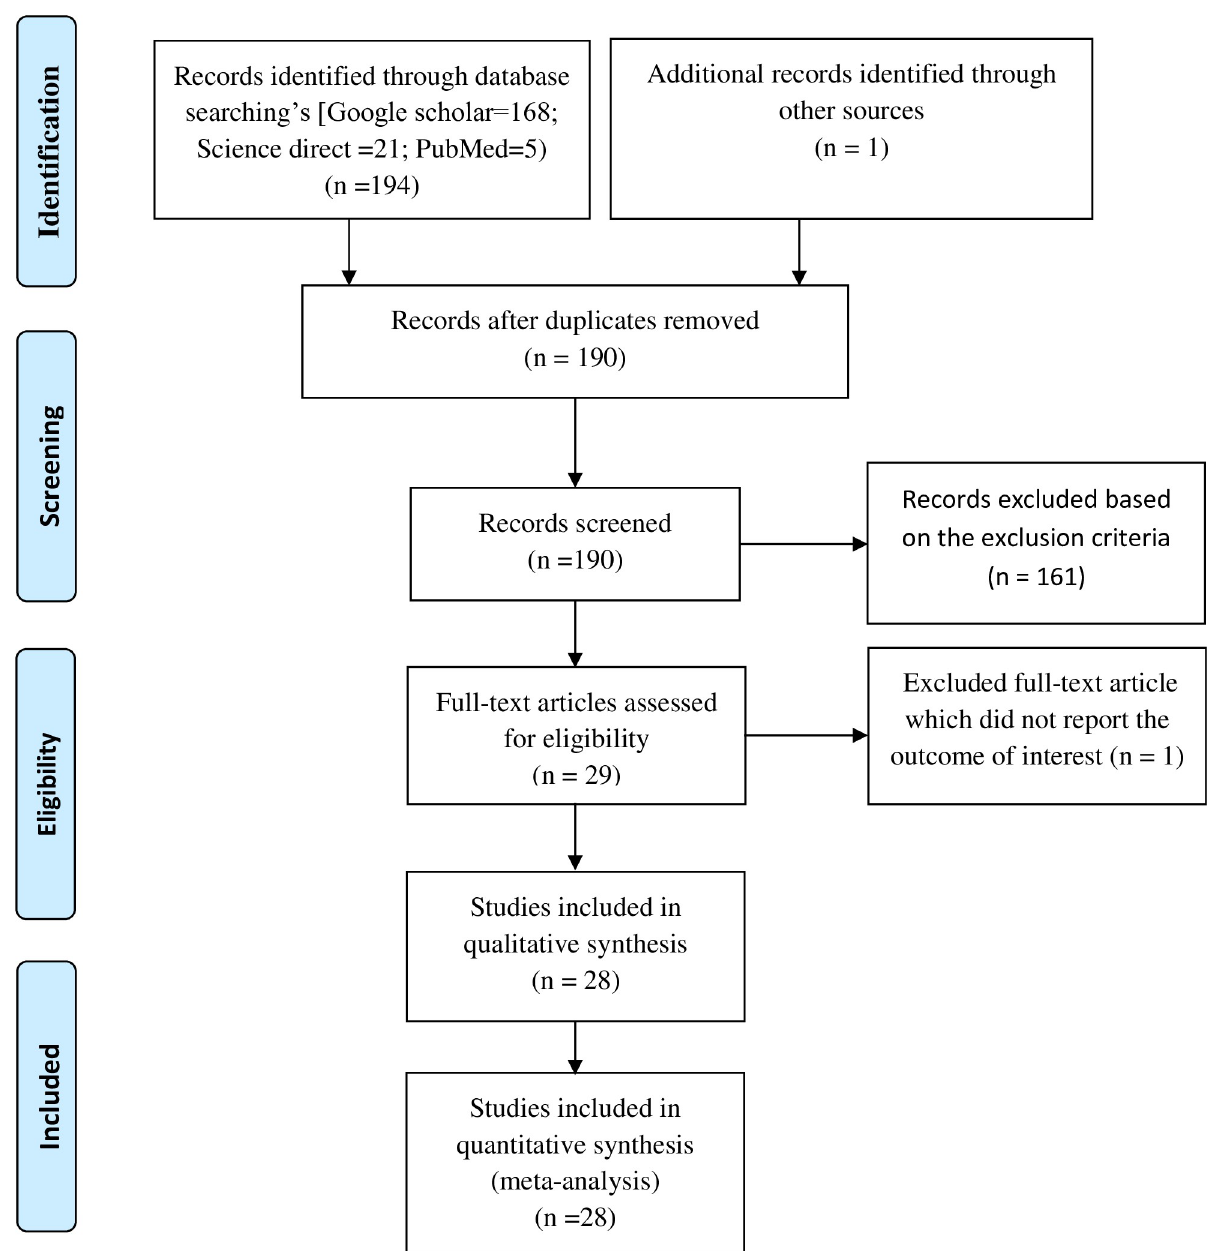
Fig 1. PRISMA flow chart which shows the selection of included